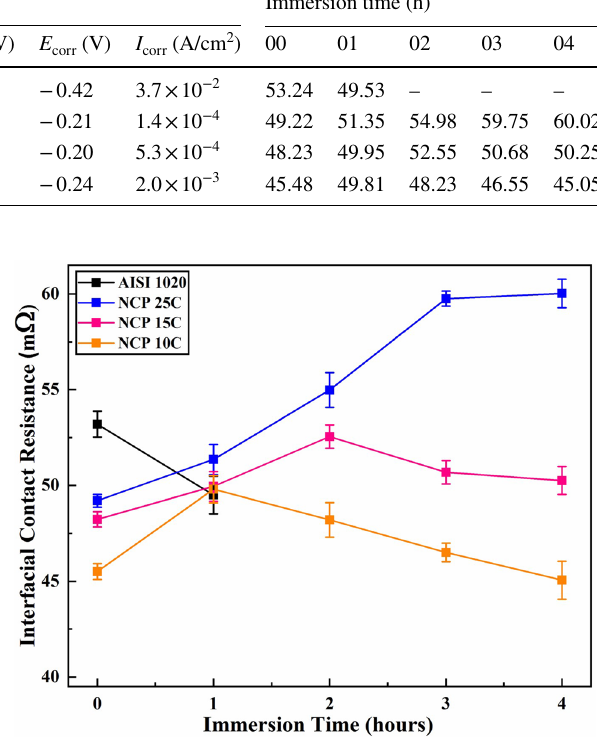
Table 1 Summary of chromium content, corrosion parameters, and ICR of AISI 1020 and Ni–Cr–P specimens, electrodeposited at various tem- peratures Samples